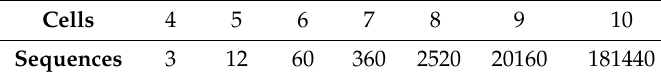
Table 1. Number of Different DC Source Switching Sequences.